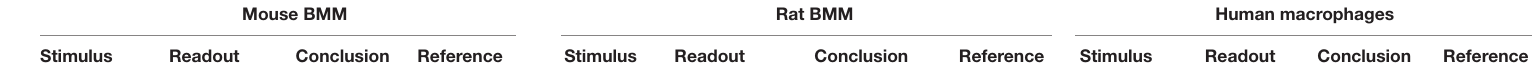
TABLe 1 | Summary of SOCS1 and SOCS3 KO, conditional KO, and siRNA knockdown studies to determine their role in polarization of mouse, rat, and human